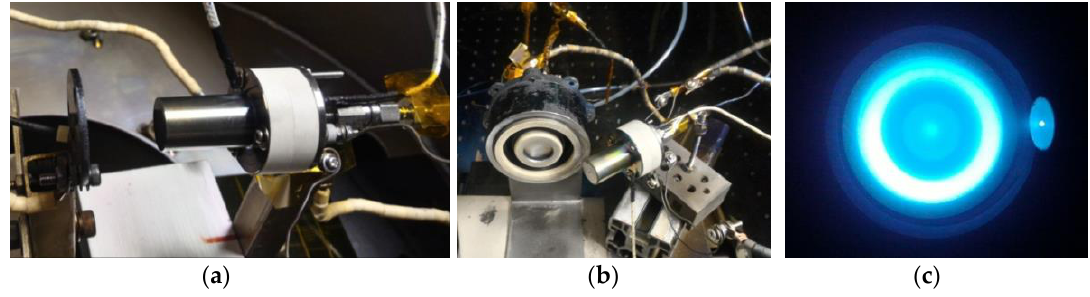
Figure 13. Knife-edge emitter cathode: ( a ) installed in the CEVAC with an external plate anode for standalone testing; ( b ) installed in the TEVAC with the 200 W-class Hall thruster [50]; ( c ) 200 W-class Hall thruster plasma plume with the knife-edge emitter cathode at 0.55 A of discharge current [50]. The cathode mass flow rate is 0.096 mg · s − 1 -Xe and the anode mass flow rate is 0.34 mg · s − 1 -Xe with a total system power of 91.5 W.